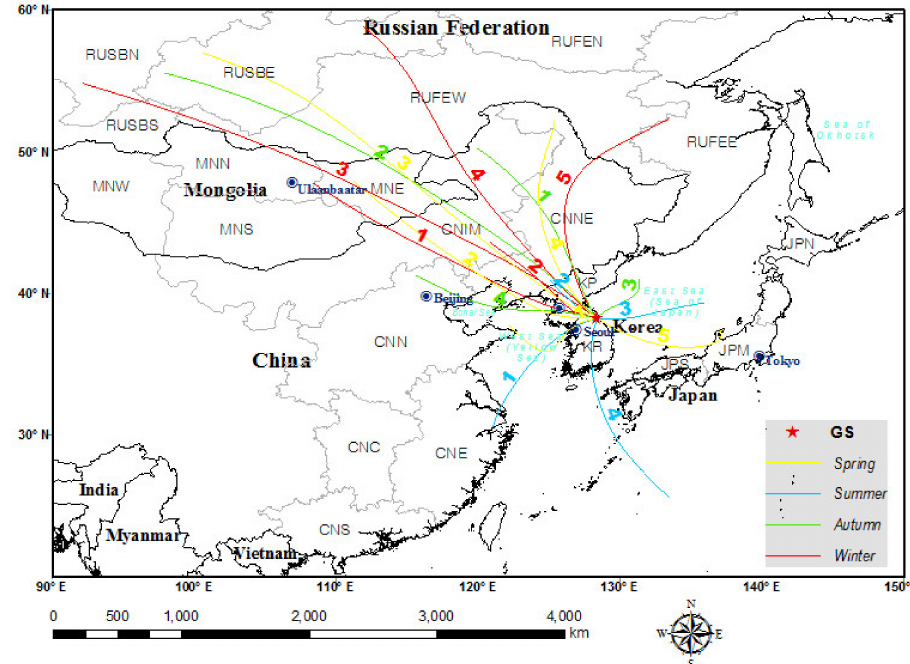
Figure 1. Location of the study site, the Ganseong (GS) represented by the red star. The colored (yellow to red) lines show the seasonal mean trajectory clusters and indicate the main directions of air flows seasonally reaching the GS station. RUFEE: Eastern part (E) of the Russia Far East (RUFE), RUFEN: Northern part (N) of the Russia Far East, RUFEW: Western part (W) of the Russia Far East, RUSBE: Eastern (E) Siberia of Russia (RUSB), RUSBN: Northern (N) Siberia of Russia, RUSBS: Southern (S) Siberia of Russia, MNE: Eastern Mongolia (MN), MNN: Northern Mongolia, MNS: Southern Mongolia, MNW: Western Mongolia, CNC: Central (C) China (CN), CNE: Eastern China, CNIM: Inner Mongolia (IM) of China, CNN: Northern China, CNNE: Northeastern (NE) China, CNS: Southern China, KP: North Korea, KR: South Korea, JPM: Mid (M) Japan (JP), JPN: Northern Japan, JPS: Southern Japan. The numbers in bold with seasonally di ff erent colors denotes the individual clusters in each